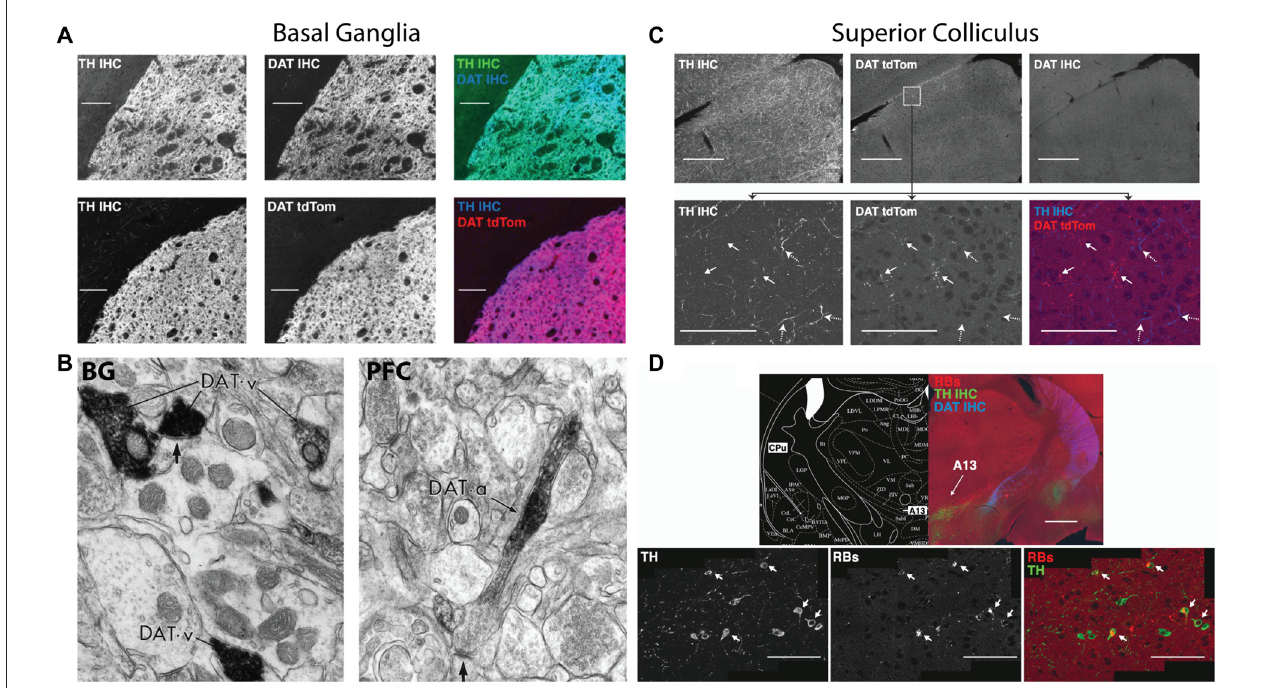
FIGURE 2 | Dopamine transporter (DAT) expression varies across the brain in terms of expression and localization on dopaminergic axons. Immunohistochemistry for tyrosine hydroxylase (TH IHC), the enzyme required for making dopamine, was performed as a double stain with DAT or on a DAT-tdTomato transgenic mouse. In the basal ganglia (BG), DAT and TH strongly overlap in terminals originating from the midbrain dopaminergic cell groups. The DAT in these BG terminals clusters in presynaptic terminals that release dopamine ( B , left, reprinted with permission from Sesack et al., 1998), indicating that dopamine reuptake is the main mode of action after dopamine release in the BG. The superior colliculus (SC; C ), on the other hand, receives TH+ axons that are DAT negative. SC axons in the DAT-tdTomato mouse that stain positive for DAT do not actually contain TH. Dopamine axons in the SC arrive from the A13 cell group (D) , which is labeled by retrograde injections from the SC (Retrobeads = RB). A13 is a dopaminergic cell group in the zona incerta of the diencephalon that does not express DAT ( D , top). A subset of TH+ axons in the SC are noradrenergic from the locus coerelus (RBs also found in the LC: data not shown here, but shown in Bolton et al., 2015). Also note that the DAT+ axons coming from the midbrain and terminating in the BG in (A) can be seen traversing the diencephalon in (D) . Therefore, the two modes of dopamine clearance (DAT+ and DAT − ) can both be seen in this